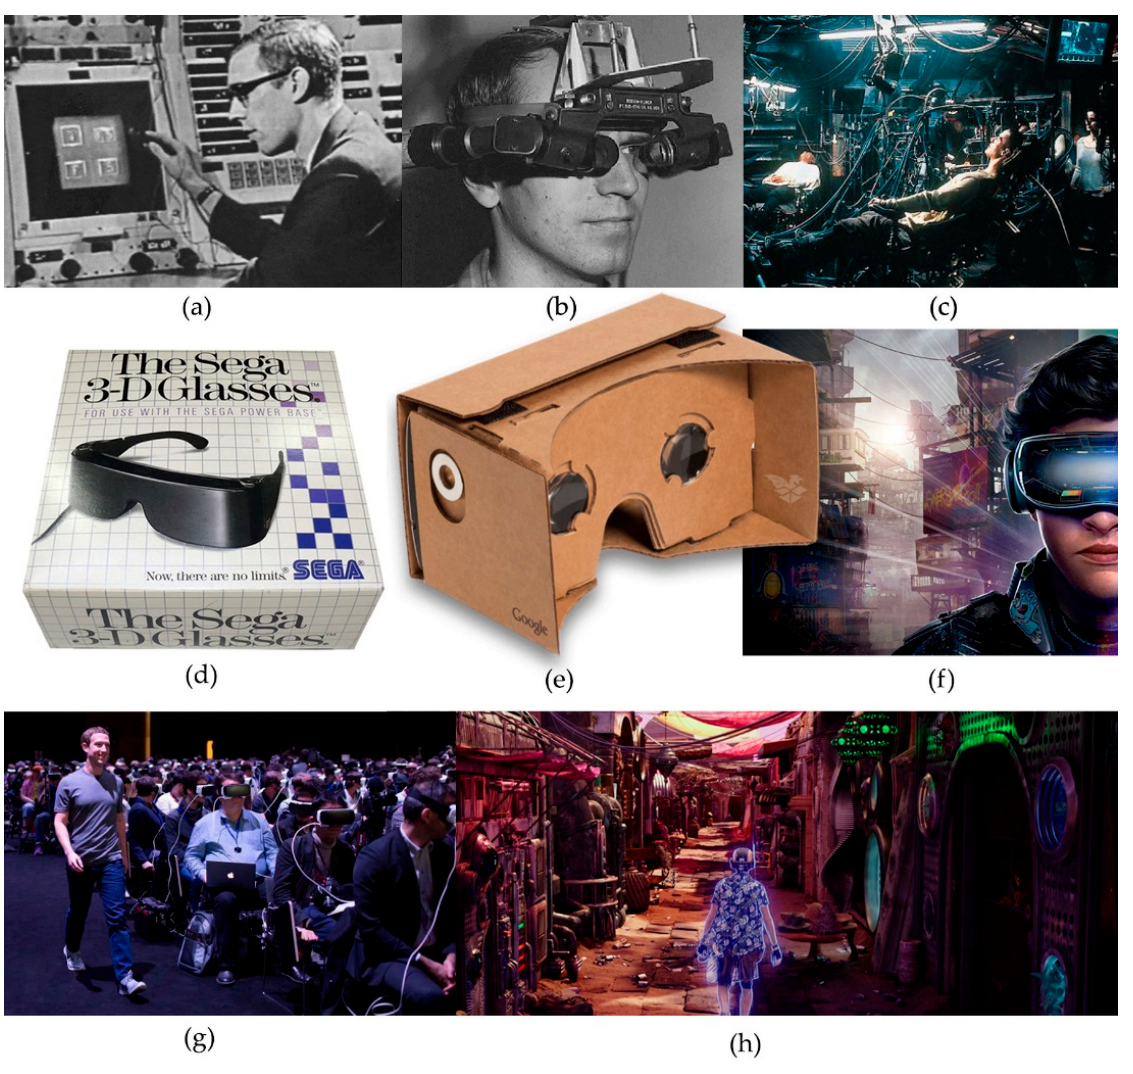
Figure 1. ( a ) On the left: Timothy Johnson working with Sketchpad III and ( b ) Ivan Sutherland’s head-mounted 3D display (1968). Both devices were precursors of current technology influencing cinema and science fiction: ( c ) The Matrix (1999), directed by the Wachowski sisters; ( d ) 3D Glasses or SegaScope 3-D from the Master System, designed by Mark Cerny (1987); ( e ) Google Cardboard as a low-cost VR system (2014); ( f ) Ready Player One (2018), directed by Steven Spielberg; and finally; ( g ) Mark Zuckerberg at an Oculus demo; ( h ) Valérian et la Cité des mille planètes (2017), directed by Luc Besson, proposing an alternative to tourism through virtual reality.